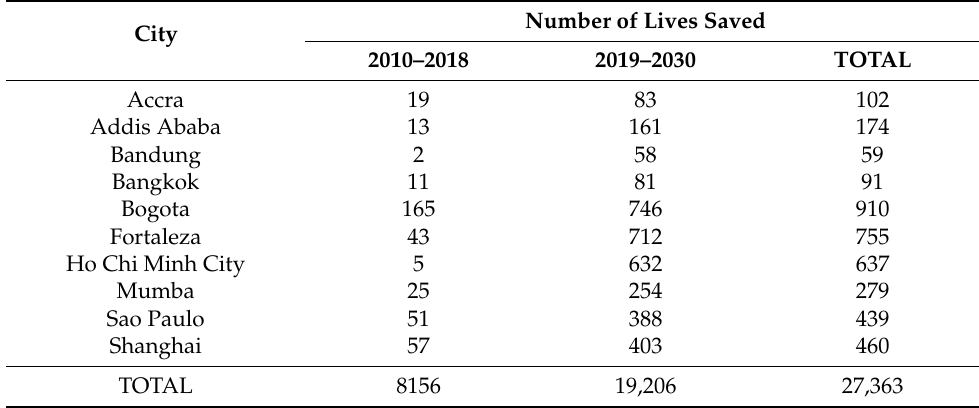
Table A6. Estimates of Lives Saved from Road Infrastructure Improvements Implemented as a Result of the BIGRS (2015–2019).